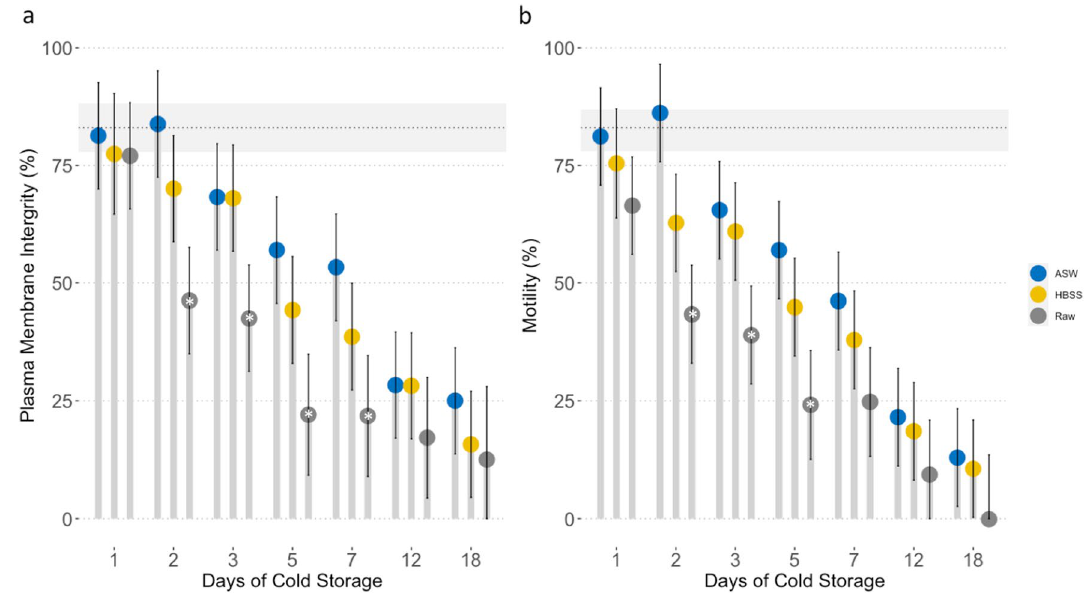
Figure 2. The effect of cold storage on whitespotted bamboo shark Chiloscyllium plagiosum ejaculates. Plasma membrane integrity ( a ) and motility ( b ) of ejaculates cold-stored raw or extended with elasmobranch modified Hank’s balanced salt solution (E-HBSS) or artificial seawater (ASW) and initial mean (dotted line) and standard error (grey rectangle) of ejaculates. Treatment bars are capped with a circle (estimated marginal mean) and error bars (95% confidence interval). *Indicates significant difference among treatments at each time point ( p < 0.05).